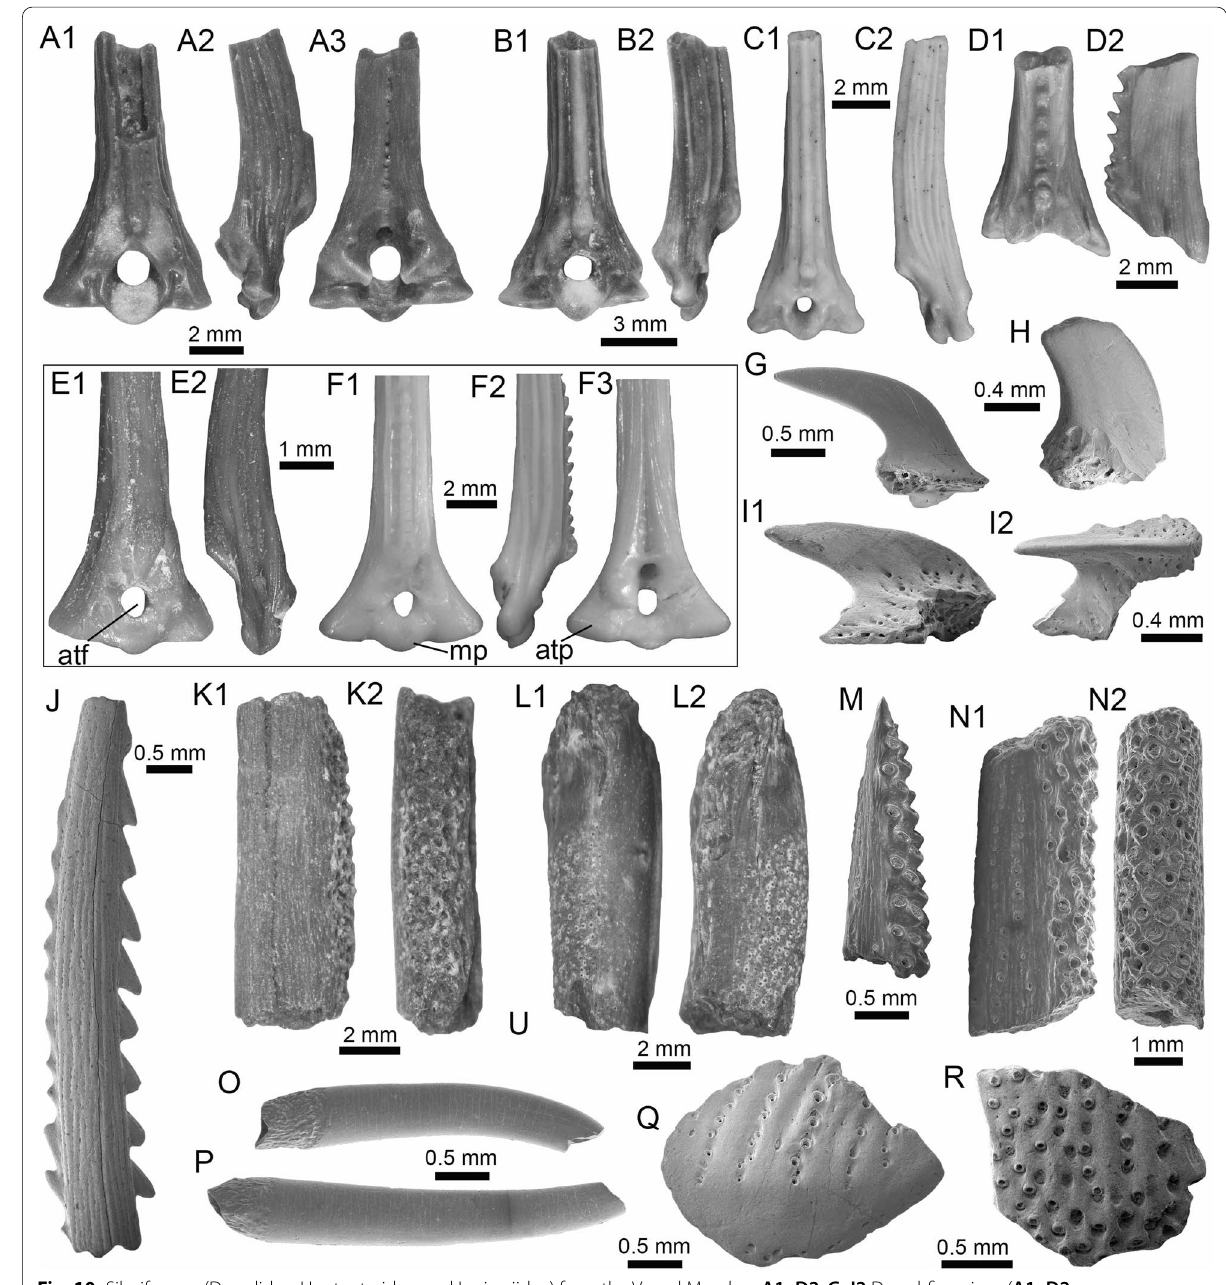
Fig. 10 Siluriformes (Doradidae, Heptapteridae, and Loricariidae) from the Vergel Member. A1 – D2 , G – I2 Dorsal‑fin spines ( A1 – D2 AMU‑CURS‑1180) and mid‑lateral scutes ( G , H AMU‑CURS‑864a‑b and I1 , I2 AMU‑CURS‑1232a) of Doradidae indet. E1 – F3 Dorsal spines of extant Anadoras wedellii ( E1 , E2 AUM‑45441) and Scorpiodoras heckelii ( F1 – F3 MHNLS‑17959). J Pectoral spine of cf. Pimelodella sp. (AMU‑CURS‑1183). K1 – P Pectoral spine fragments ( K1 – l2 AMU‑CURS‑1173 and M – N2 AMU‑CURS‑817), and odontodes ( O , P AMU‑CURS‑876) of Hypostominae indet. Q , R Body plates of Loricariidae indet. (AMU‑CURS‑1230). Views: anterior ( A1 , B1 , C1 , D1 , E1 , F1 , K2 , L1 , N2 ), lateral ( A2 , B2 , C2 , D2 , E2 , F2 , I2 , O – P ) posterior ( A3 , F3 ), and indet. ( G – I1 , J , K1 , L2 , M , N1 , Q – R ). atp anterior process, atf articular foramen, mp medial